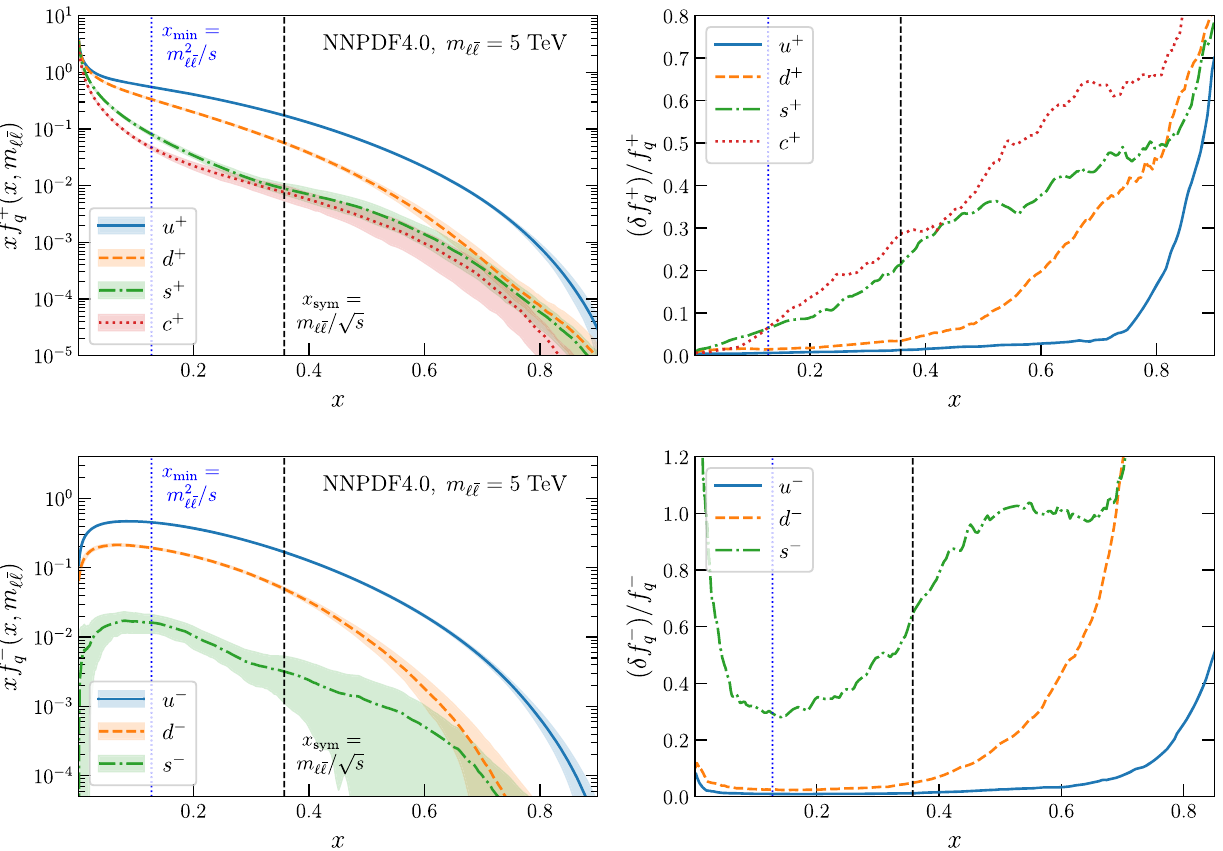
Fig. 8 Comparison of the x f + q (top) and x f − q (bottom) quark PDF combinations for the up, down, strange, and charm quarks, evaluated at m (cid:2) ¯ (cid:2) = 5 TeV for NNPDF4.0 NNLO. The right panels display the rela- tive68%CLuncertainties.Thetwoverticallinesindicate x min = m 2